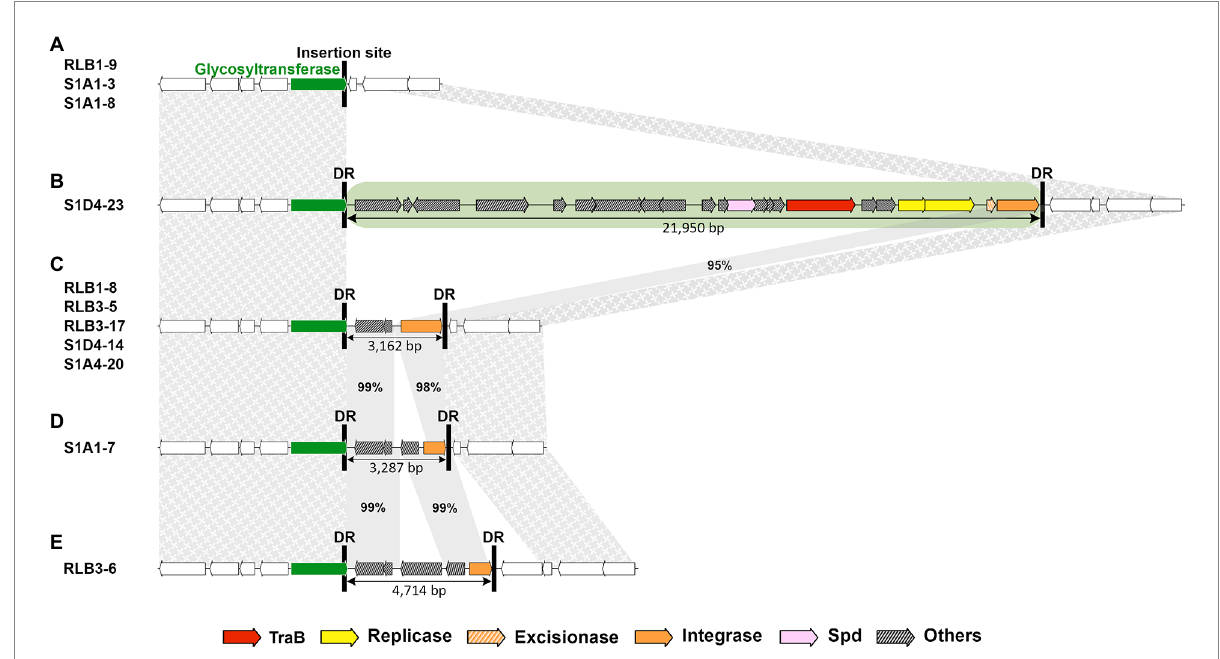
FIGURE 4 AICE decay. An example of AICE content at the same insertion site in different strains of the Streptomyces population. While some strains (A) harbored an empty site (in this instance, within a glycosyltransferase gene represented by the green arrow), S1D4-23 (B) possessed a fully functional AICE (family 06 highlighted in green). The strains depicted in (C) , (D) and (E) carry remains of cargo genes and truncated integrases between the direct repeats (black vertical bars; DR) inherited from an original AICE integrated at this site that have decayed to different degrees. Sequences upstream and downstream of the AICE insertion (including the empty site) is syntenic (textured grey areas), except for the gene encoding a transposase present in S1D4-23 and RLB3-6. The horizontal green arrow corresponds to the insertion site (phospholipid carrier- dependent glycosyltransferase). The size (in base pairs) of the AICE and decayed versions is specified below the elements. The grey bands show the conserved regions between the AICE and degenerate elements with the percentage of nucleotide